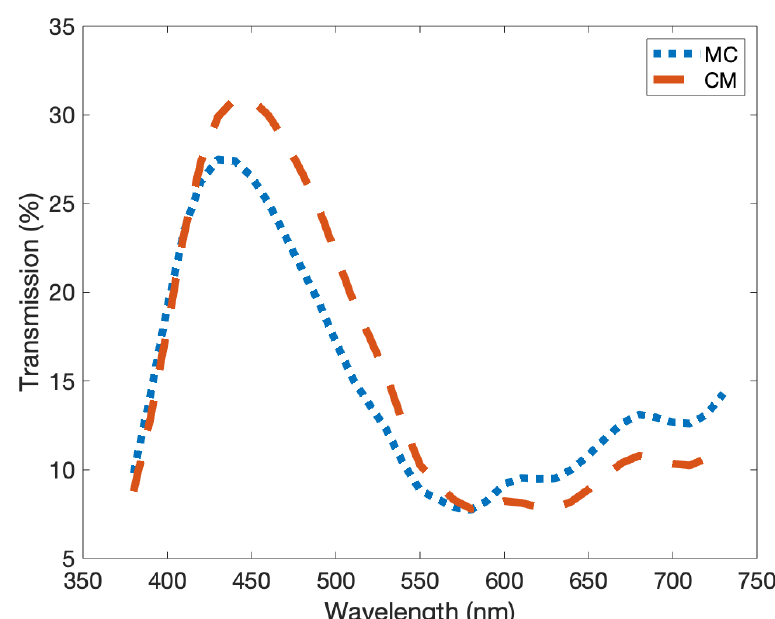
Figure 13. The predicted transmission of two second-order prints of cyan and magenta and the reverse order. The peak value moves from 30% at 440 nm to 27.5% at 430 nm. Note how the colour printed last influences the character of the transmission more